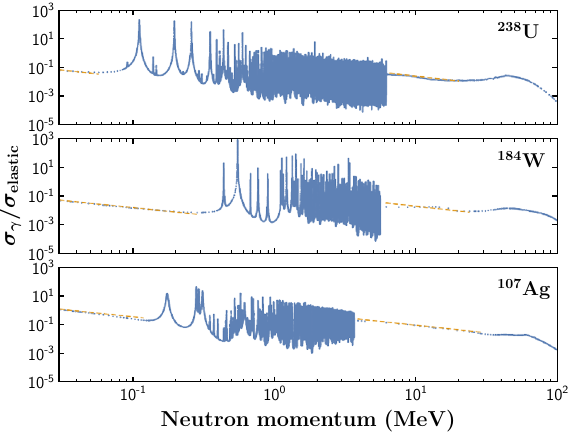
Figure 6 . Ratio of the radiative capture to elastic cross sections for neutron capture by three di(cid:11)erent nuclei using the TENDL-2017 model [26, 27] in blue color. The dashed orange lines indicate a 1 =v behavior expected at energies below the nuclear resonances and at energies above the nuclear resonances, but below onset of free nucleon